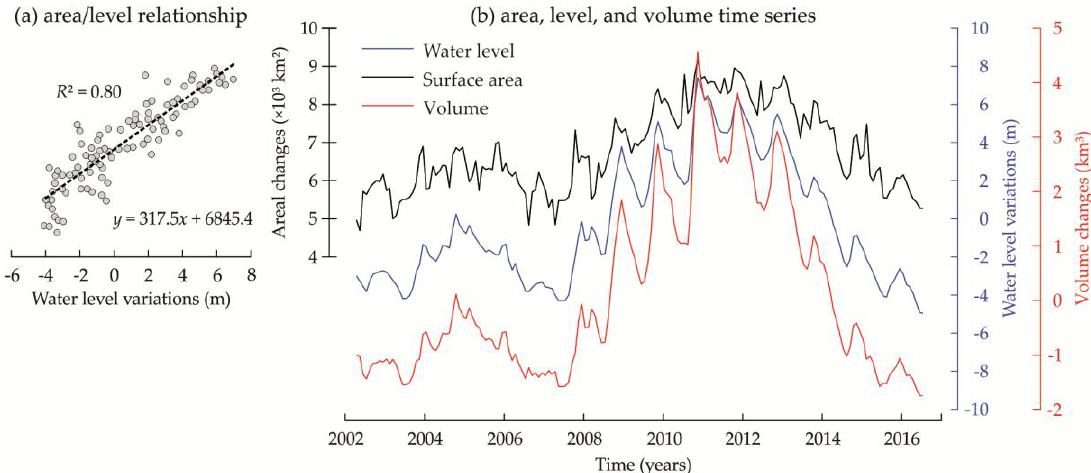
Figure 2. ( a ) Scatter plot of the area and elevation relationship. ( b ) Time series of surface area changes of Lake Volta shown with a black solid line and the altimetry heights changes represented as a red line for the entire 172-month study period after making provisions for the missing months using an area–elevation relationship (Equation (11)).